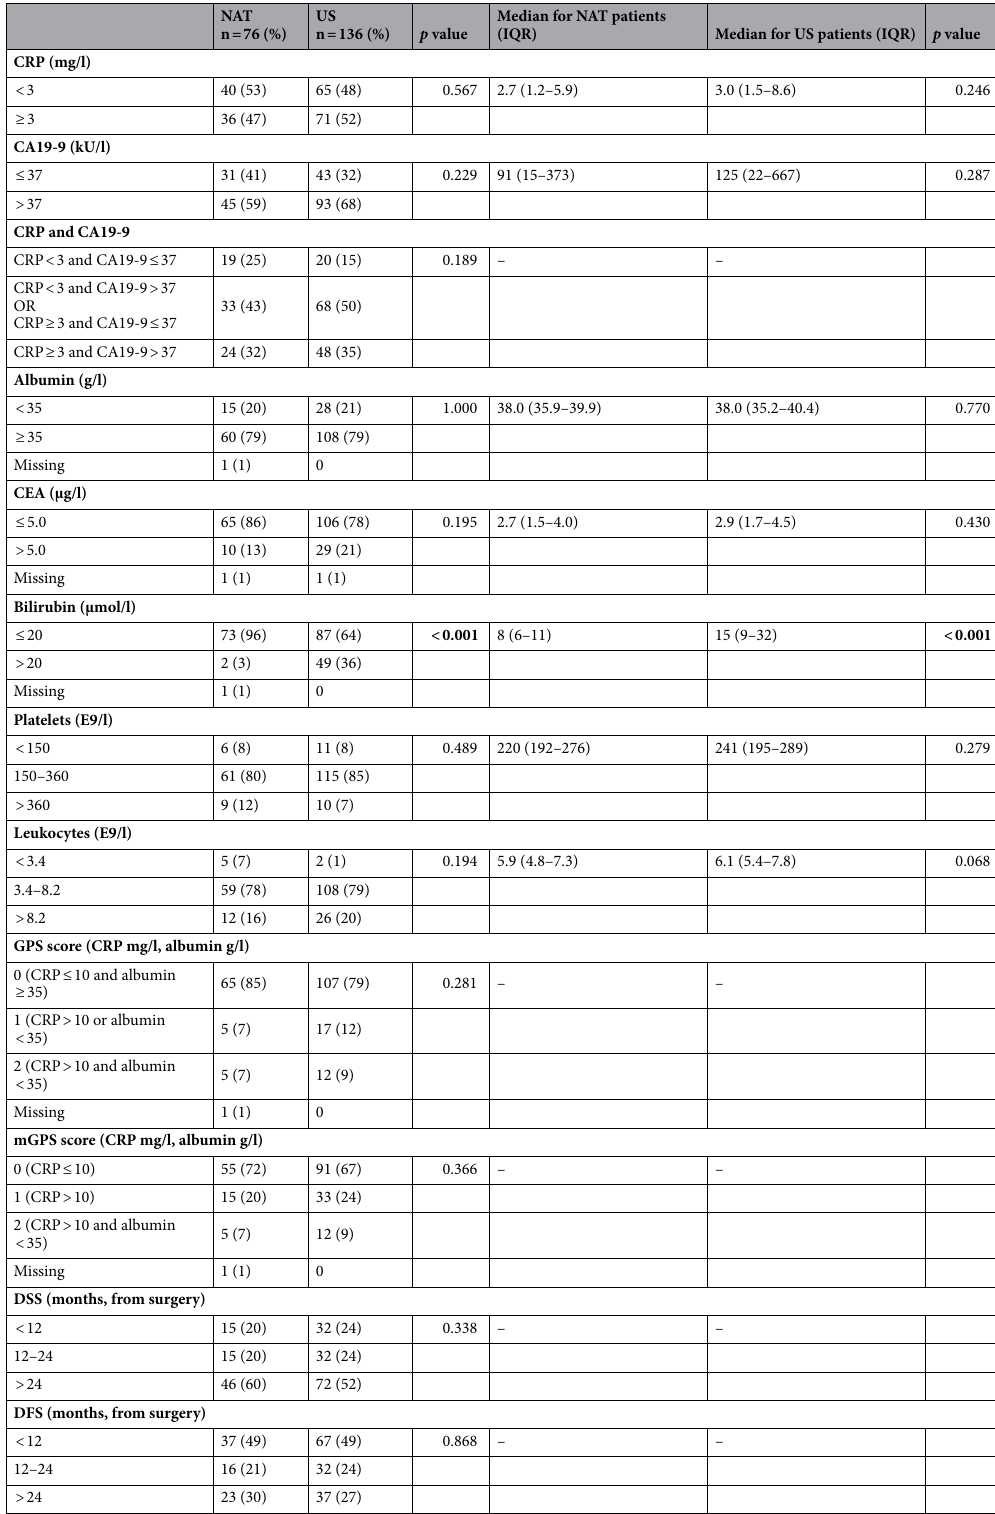
Table 1. Cut-off values with the number of patients and comparison of median values between NAT patients and those undergoing upfront surgery. We used the manufacturer’s recommended cut-off values for CRP, CEA, platelets, bilirubin, and leukocytes, and for CA19-9 based on the literature 26 and for albumin as in the Glasgow prognostic score 27 . For the Glasgow prognostic score (GPS) 27 and the modified Glasgow prognostic score (mGPS) 28 , cut-off values for CRP and albumin are based on literature. IQR interquartile range, NAT neoadjuvant therapy, US upfront